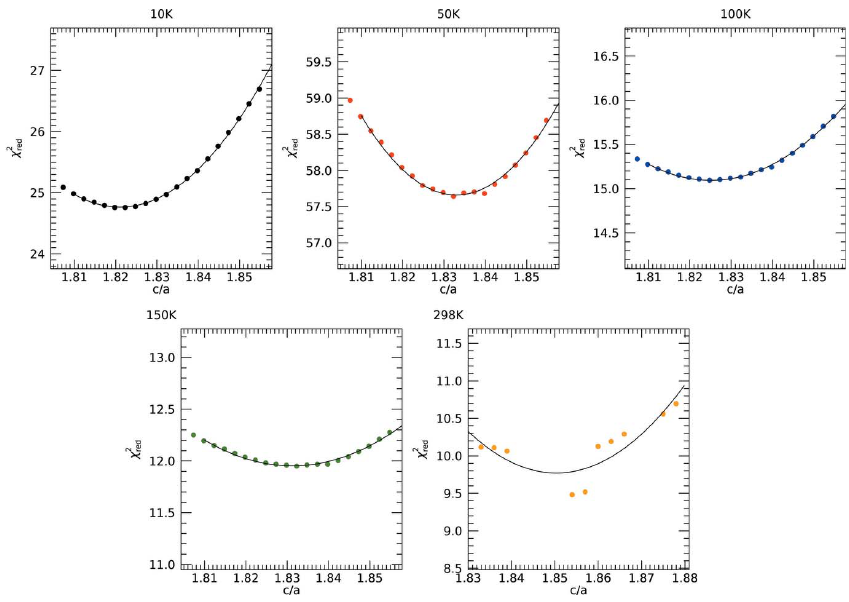
Figure 12 Results of a grid search of c / a in steps of 0.003 with eFEFFit yielding smooth quadratics (Table